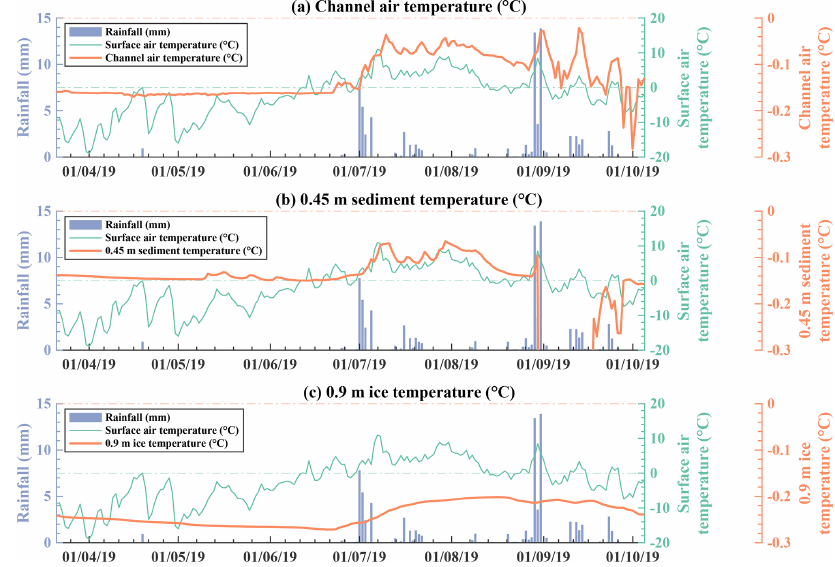
Figure 8. Subglacial temperatures at location Subglacial 1. (a) Time series of daily mean channel air temperature, modeled surface air temperature and modeled rainfall. (b) Time series of daily mean 0.45m depth sediment temperature, modeled surface air temperature and modeled rainfall. (c) Time series of daily mean 0.9m depth ice temperature, modeled surface air temperature and modeled